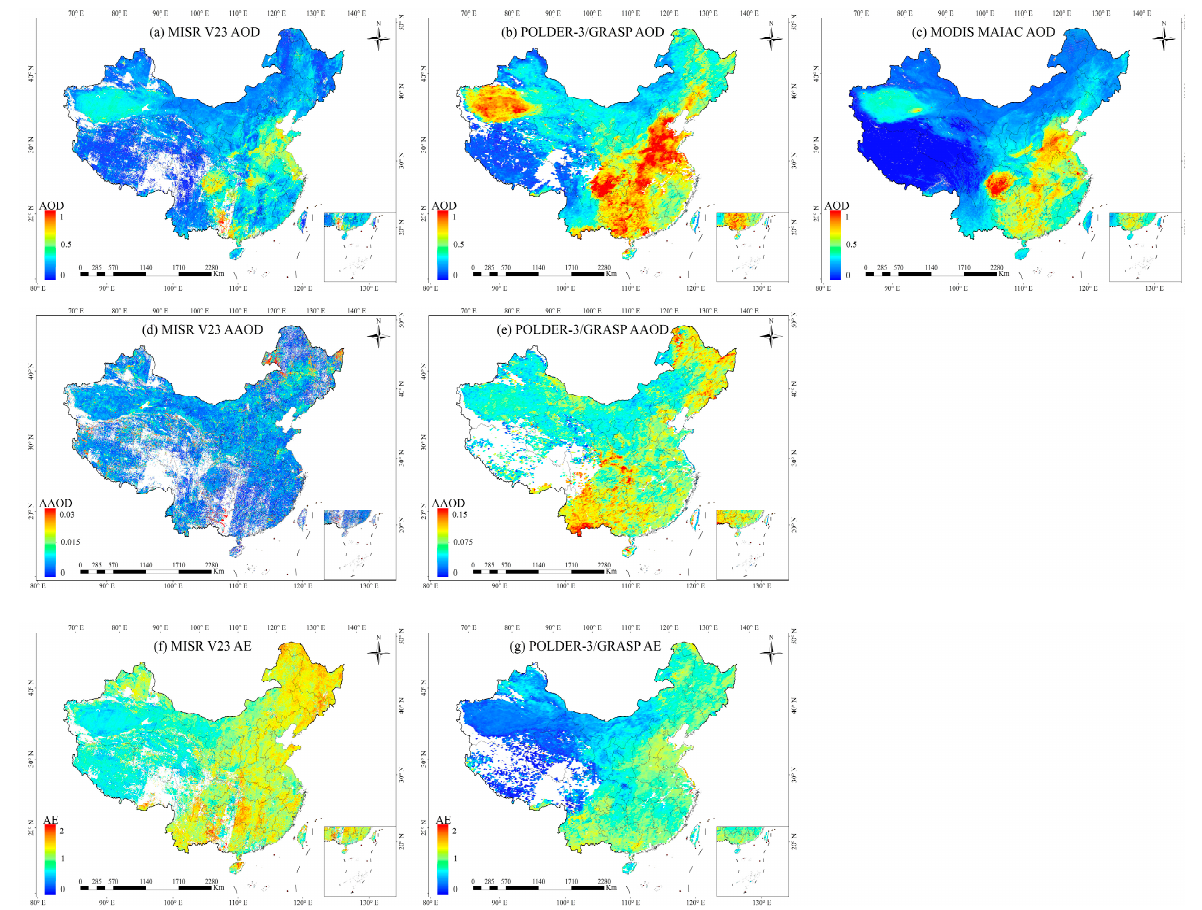
Figure 12. Distributions of annual mean value from MISR V23 products (( a ) AOD at 558 nm; ( d ) AAOD at 558 nm; ( f ) AE at 550–860 nm), POLDER-3/GRASP products (( b ) AOD at 558 nm; ( e ) AAOD at 558 nm; ( g ) AE at 550–860 nm), and MODIS MAIAC product (( c ) AOD at 550 nm) in 2012.